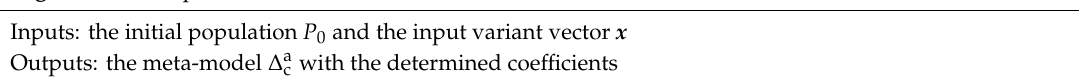
Algorithm 1 The pseudo-code to finalize the meta-model.